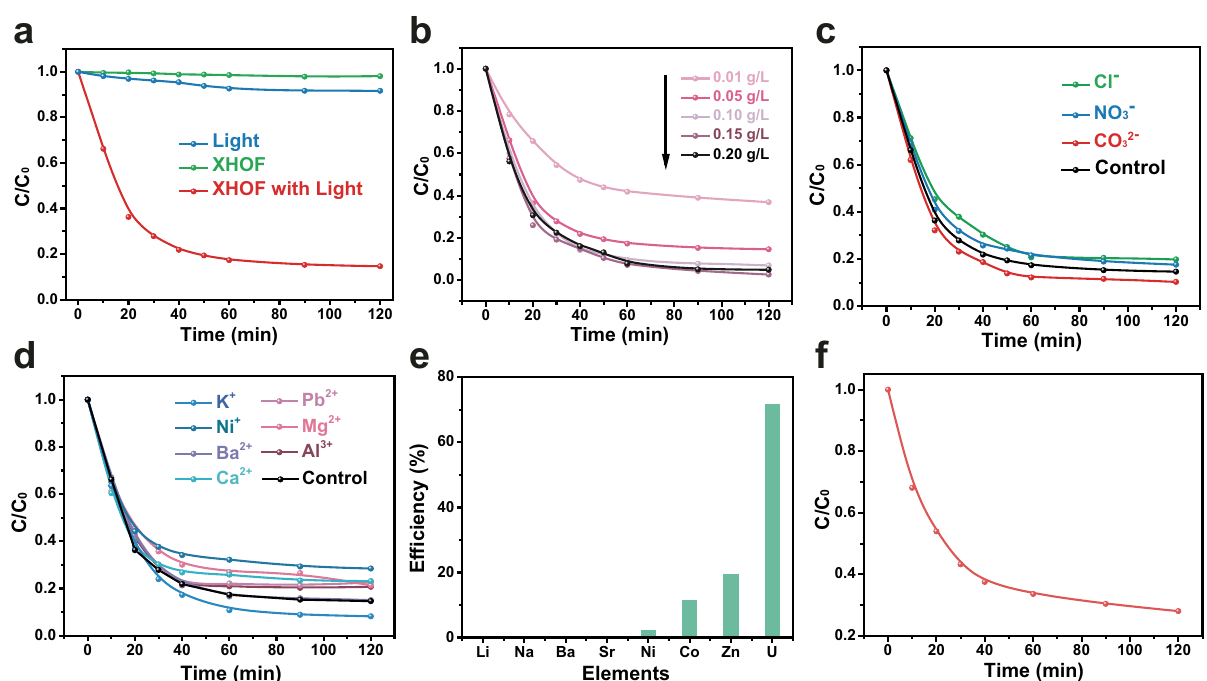
Fig. 5 The photoreduction performance of XHOF-TAQ to U(VI). a Essential factors for the photoreduction of U(VI) by XHOF-TAQ. b In fl uence of XHOF- TAQ dosage on the photoreduction ef fi ciency. c Effect of anions on the photoreduction ef fi ciency. The sodium salt of each anion with a concentration of 10 mM is used. d Effect of cations on the photoreduction ef fi ciency. The chloride salt of each cation with a concentration of 10 mM is used. e Effect of mixed interfering metal ions on the photoreduction ef fi ciency. The nitrate of each metal ion with an individual concentration of 10 mM was used. f The photoreduction kinetics obtained for U in co-existence with mixed interfering metal